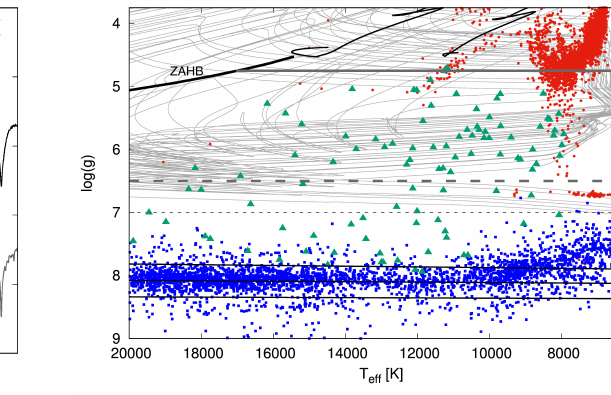
Figure 2. Red dots show the fitted O, B, A type objects. The white dwarfs of Kepler et al. (2016) are shown as blue squares, and the known ELMs as green triangles for comparison. The zero-age hori- zontal branch (ZAHB), above which stars are burning He in the core, is indicated. The remaining black lines are single evolution models for 1.0, 2.0 and 3.0 M ⊙ and Z=0.004 calculated with the LPCODE (see Althaus et al. 2003 and references therein). The horizontal lines indicate the upper limit in log g for main sequence A stars (4.75) and the lower limit for white dwarf stars (6.5–7.0). The grey lines are the binary evolution models of Istrate et al. (2016), taking into account stellar rotation. Both the ELMs and the sdAs can be explained by these